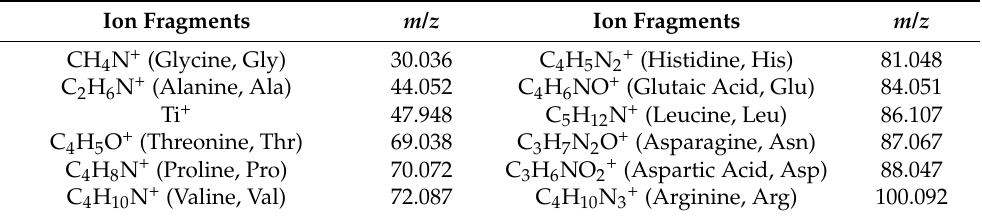
Table 1. Most intense peaks characteristic of the proteins, observed in all positive spectra of the titanium alloy coated with human serum albumin (HSA)